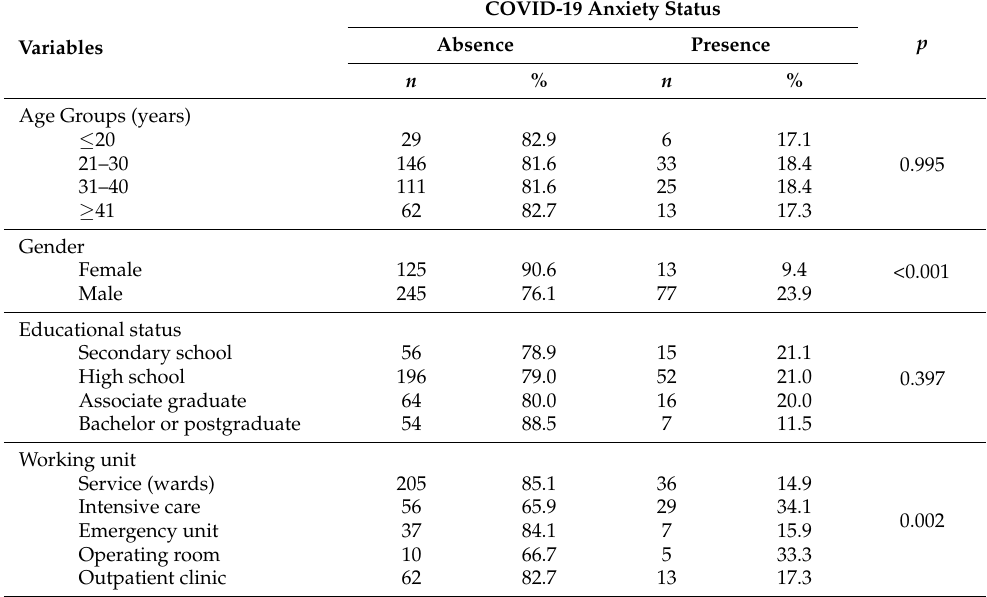
Table 3. Comparison of COVID-19 Anxiety Status of the Personnel Participating in the Study According to Various